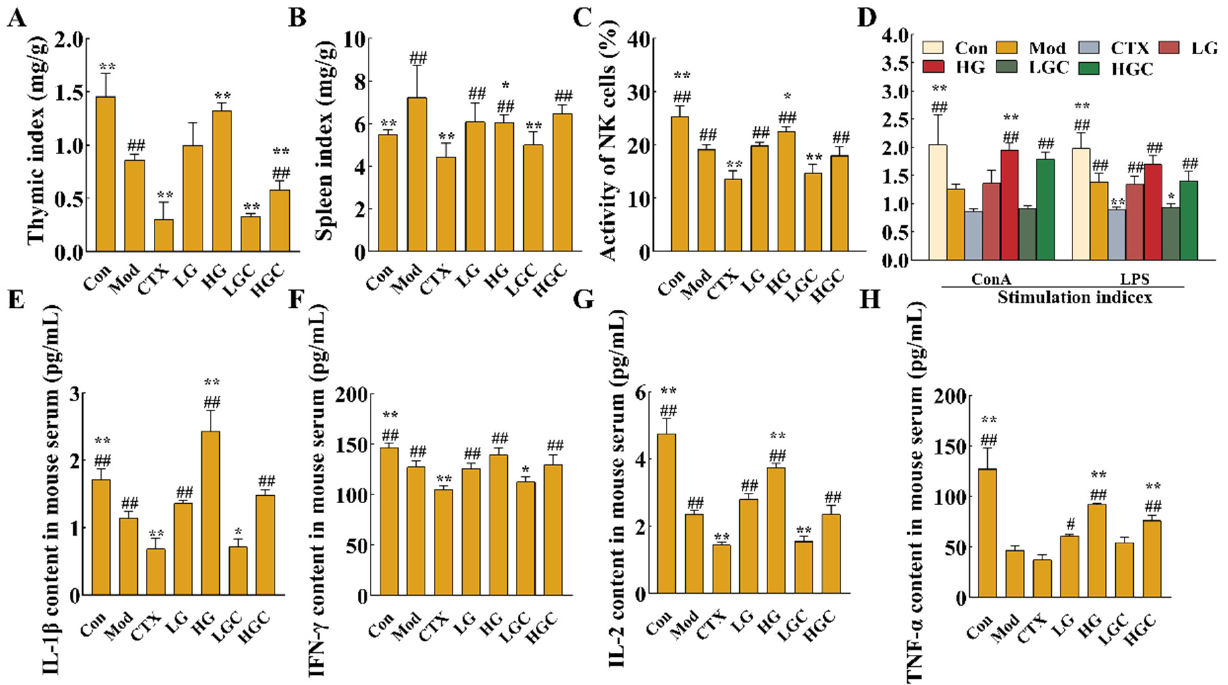
Figure 2. The immunomodulatory effects of GFG combined with CTX on H22 tumor-bearing mice. ( A , B ) Thymus and spleen index. ( C , D ) NK cell killing activity and proliferation of splenic lymphocytes. ( E – H ) Effects of GFG combined with CTX on serum IFN- γ , IL-1 β , TNF- α and IL-2 levels in H22 tumor-bearing mice. Data were expressed as the mean ± SD. * p < 0.05 and ** p < 0.01 versus the Mod group; # p < 0.05 and ## p < 0.01 versus the CTX group.